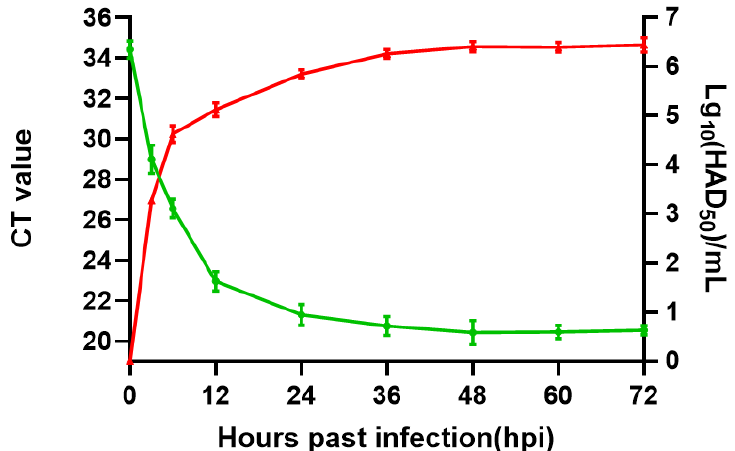
Figure 1. Proliferation and growth curves of GZ201801. Primary PAMs were infected with GZ201801 at an MOI of 1, and the supernatants and cells were mixed for infectious virus titter and viral p72 gene CT value by using HAD and qPCR assays, respectively.